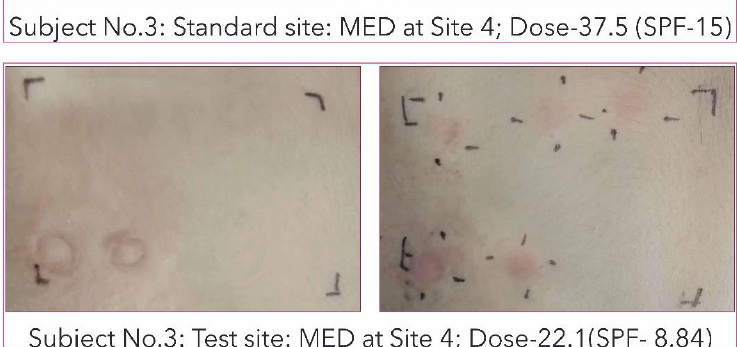
Figure 3. Sample Macro photography of the in vivo SPF determination of pterostilbene. Table 4. Sun protection factor of pterostilbene cream.